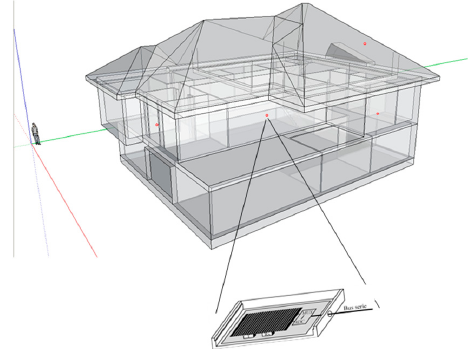
Figure 2. Location of low-cost radiation sensors in a building.